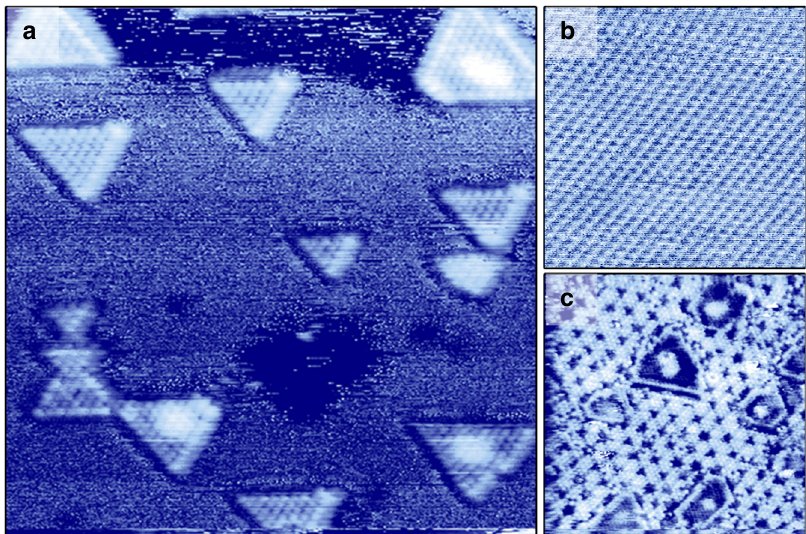
Fig. 1 STM images of a MoS 2 /Au(111) model catalyst and its stability under desulfurization conditions. a Catalyst after preparation in UHV. 16× 16 nm 2 , U bias = − 0.3V, I t = 320 pA. b Clean Au surface imaged in 1 bar CH 3 SH at 250 °C, showing the (1× 1) Au lattice. 6× 6 nm 2 , U bias = − 0.3 V, I t = 550 pA. c MoS 2 / Au(111) after 1day in 1 bar of a 1:9 CH 3 SH/H 2 mixture, showing a sulfur overlayer on the Au(111) substrate. 20× 20nm 2 , U bias = − 0.3V, I t = 645